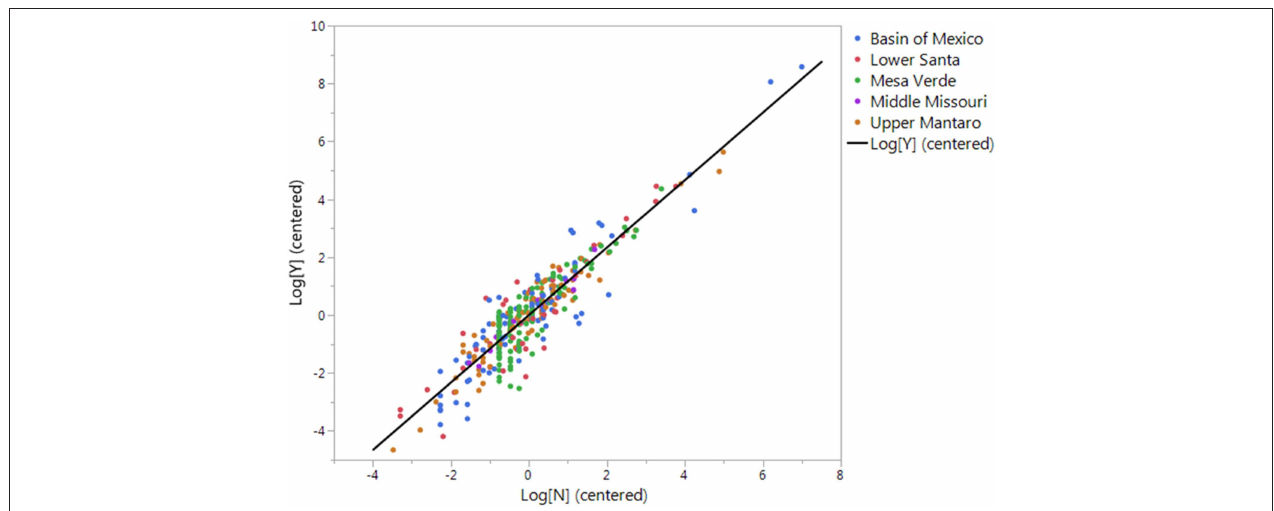
FIGURE 2 | Evidence that house areas follow a single scaling relationship across societies. In this plot, the data have been centered by subtracting the mean coordinates of the data for each society from each data point. This process re-scales the data so that their center of the data for each society is at the origin. The estimated coefficient of the scaling relationship for the centered data is within two one thousandths of the predicted